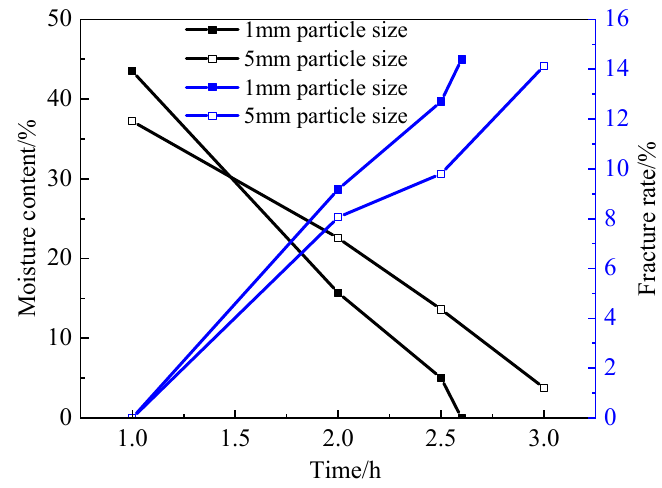
Figure 10. The relationship curves of fissure rate, moisture content and time.